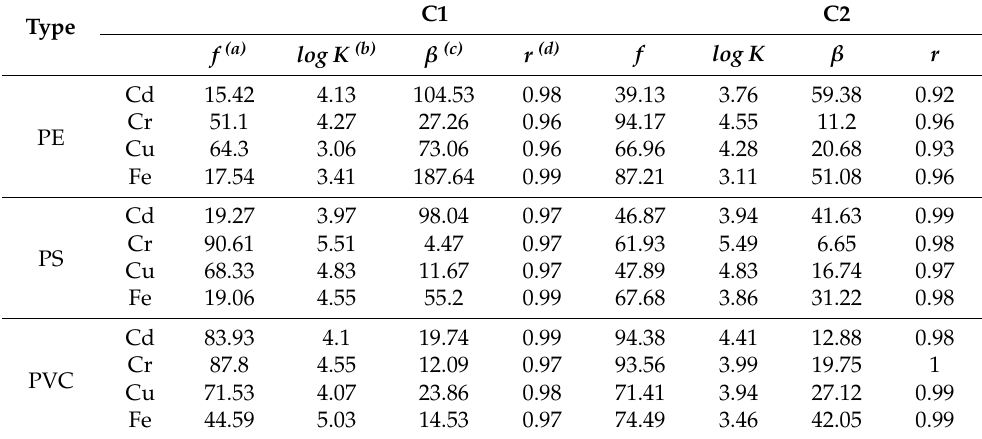
Table 2. Metal-binding parameters of two different fluorescent components calculated by the modified Stern–Volmer equation using the MP-DOM samples. Type